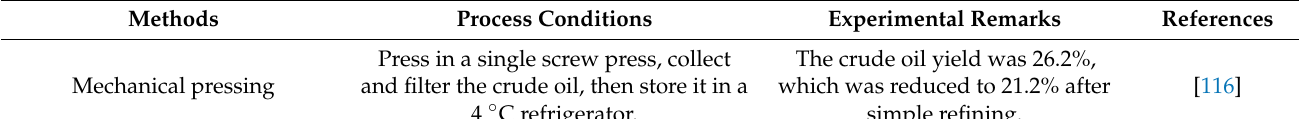
Table 6. Extraction methods and technology of Litsea cubeba kernel